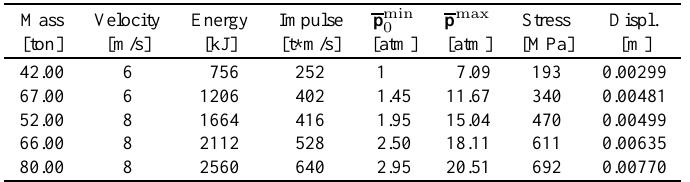
Table 3 Response of the structure calculated for various impact energies